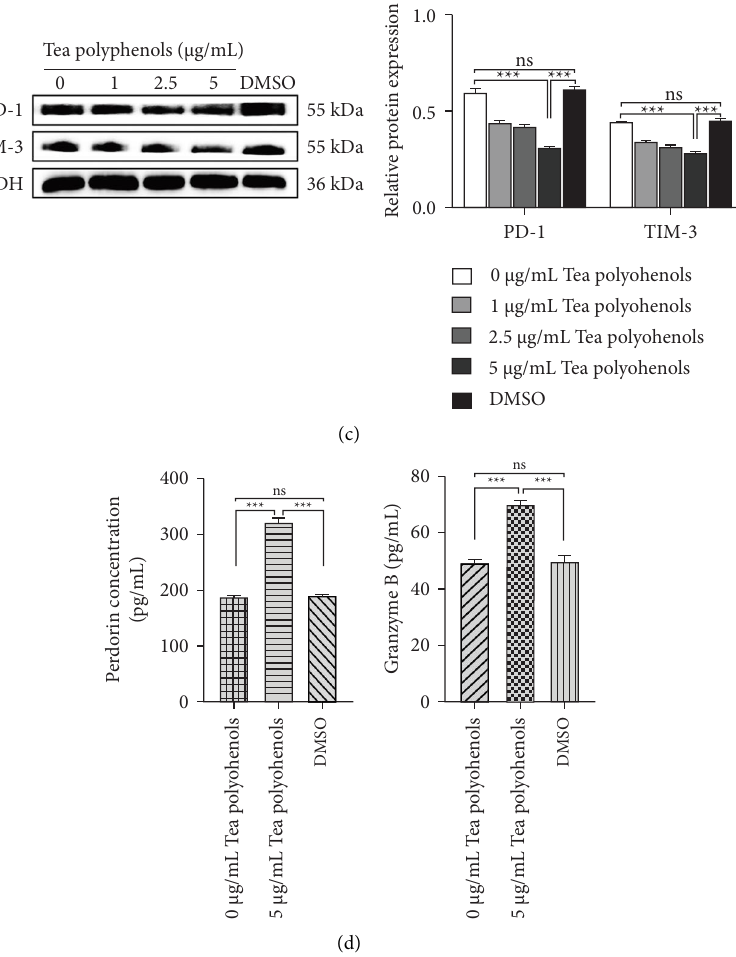
Figure 5: The reversal of CTLs depletion after treatment with TP. After the cells were cocultured for one day, different concentrations of tea polyphenols (0, 1, 2.5, and 5 μ g/mL) were added, and the cells were cultured for an additional day. (a) Western blotting analysis of GRP78, PERK, P-PERK, and CHOP expression in CTLL-2cells. (b) Cells were treated with TP (0 and 5 μ g/mL), and ER morphology was examined by electron microscopy (scale bar � 2 μ m). (c) Western blotting and (d) ELISA analysis. Data are presented as the mean ± SD. ∗∗∗ P < 0 . 001, ns indicates no statistical